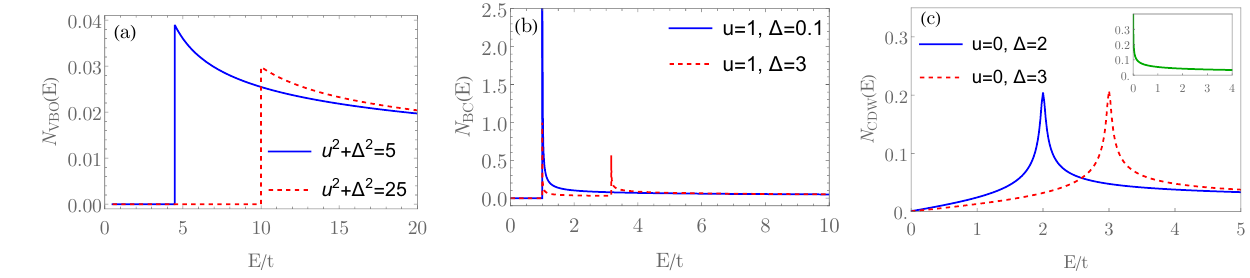
Figure 2. The density of states (DOS) in the candidate paramagnetic states. ( a ) valence-bond order (VBO); ( b ) bond-current order (BCO); ( c ) smectic charge-density wave (sCDW). The DOS in the three phases is given in Equations (7), (11), and (S69) in the SI. The energy ( E ) is in units of the bandwidth ( t ), see also Figure 1. u and ∆ are given in units of t . The inset in ( c ) corresponds to the DOS for the noninteracting case, where the low-energy DOS scales as | E | − 1/3 .